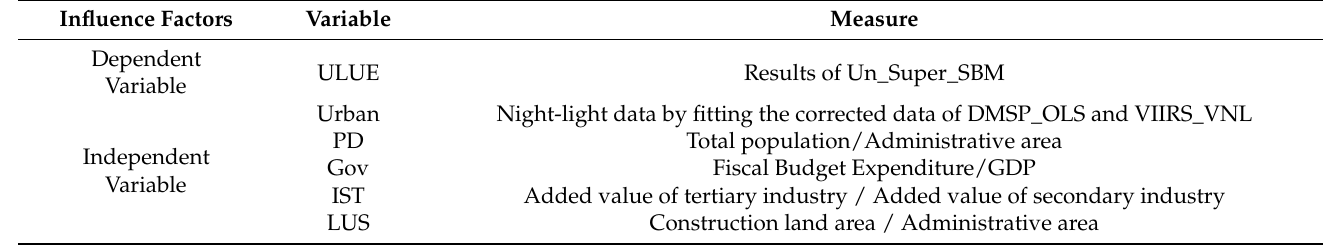
Table 2. Model variable